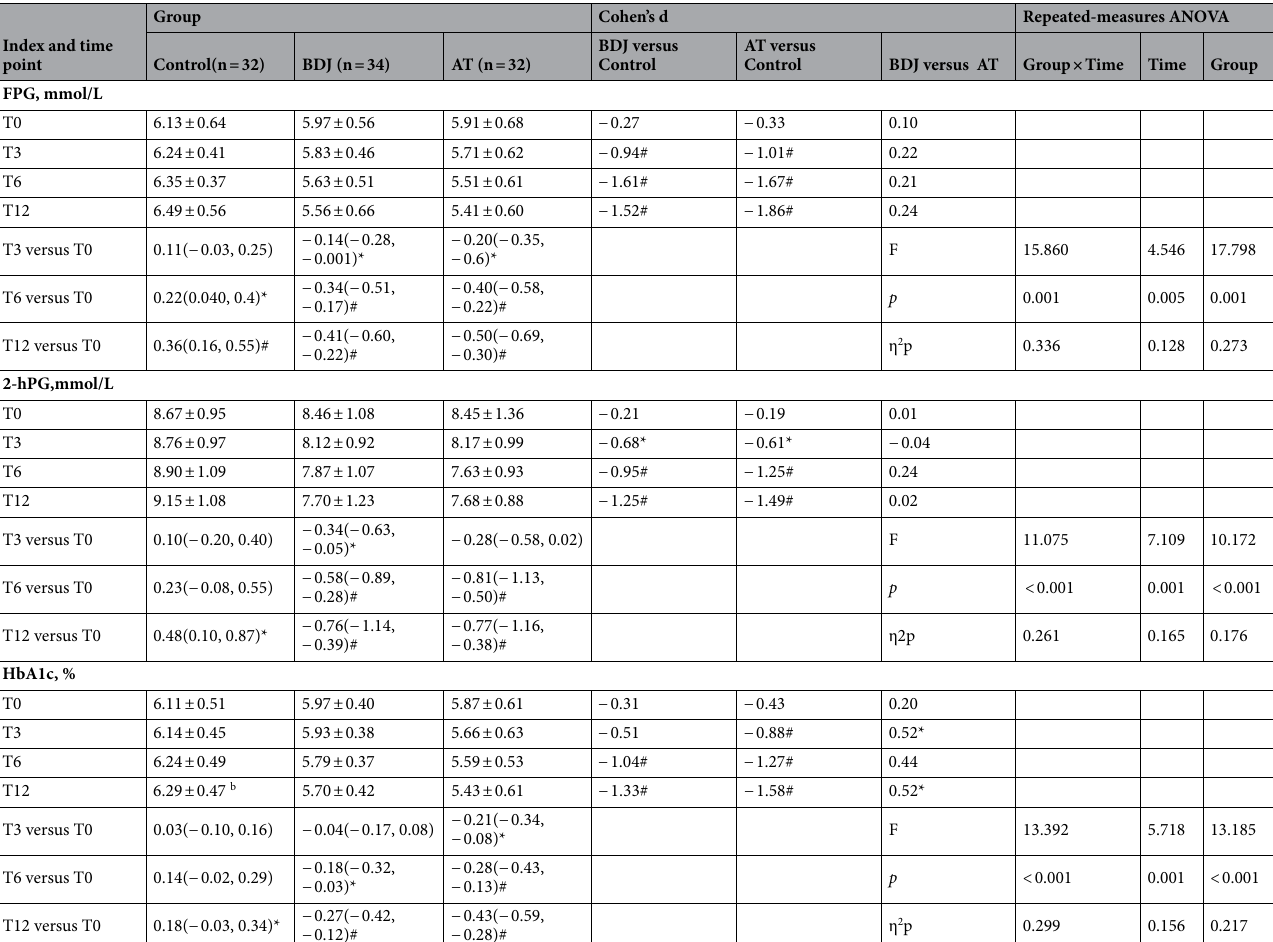
Table 2. Effects of interventions on blood glucose indicators among the three groups [mean ± SD or mean difference (95% CI)]. BDJ, Baduanjin; AT, aerobic training; FPG, fasting plasma glucose; 2-hPG, 2-h plasma glucose; HbA1c, haemoglobin A1c; η 2 p, partial eta-squared; T0, baseline; T3, at 3 months; T6, at 6 months; T12, at 12 months; *, significant difference at p < 0.05; #, significant difference at p <